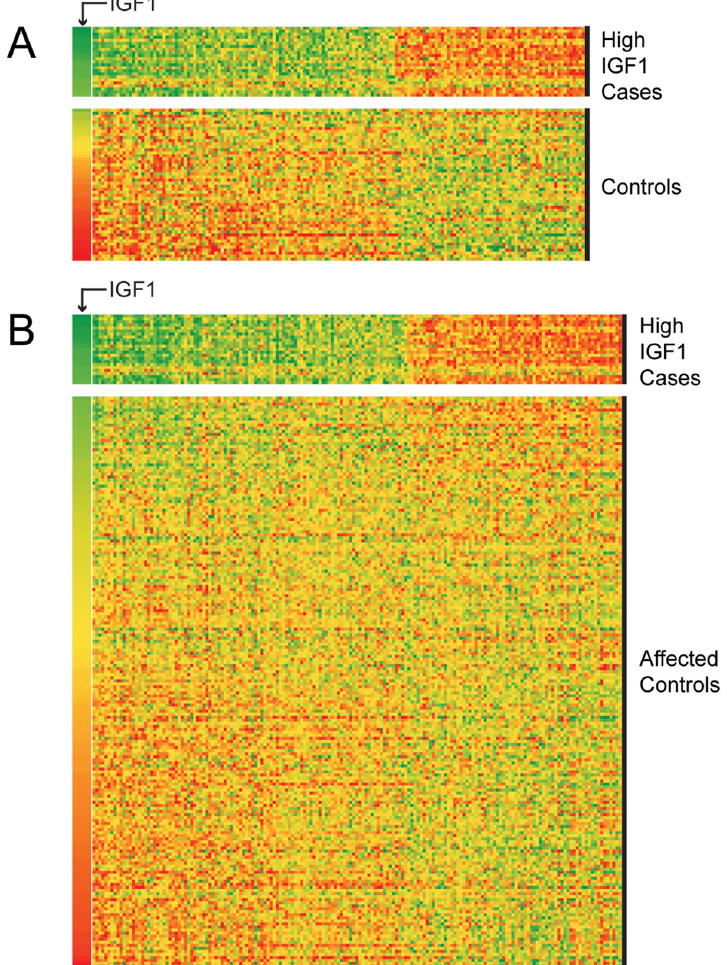
Fig 1. Heat map representation of RNA expression of genes involved with bone biology. The candidate genes of interest depicted in this heat map have a statistically significant difference in expression between (A) 23 cases with the highest IGF1 expression levels and unaffected controls and (B) 23 cases with the highest IGF1 expression levels and 188 remaining cases (affected controls). Affected controls represent SSC cases with lower IGF1 expression. IGF1 expression is shown in the far-left column (arrow) and sorted high to low. The expression of each transcript is represented with conditional formatting with green indicating highest and red representing lowest expression among individuals. Candidate gene expression is ordered left to right by the ratio of the mean expression value of the top 23 (high IGF1 cases) to the mean of unaffected controls (A) and affected control cases (B). See S1 Table for the complete gene list and statistical